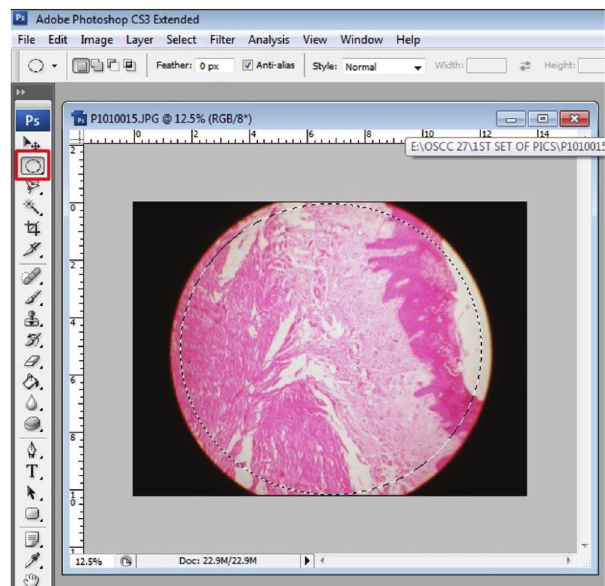
Figure 6: Select elliptical marquee tool and drag and draw a dotted line circle almost covering only the section and leaving out extraneous black portion. Note the red boxes in the figure. Follow them for an easy workflow.